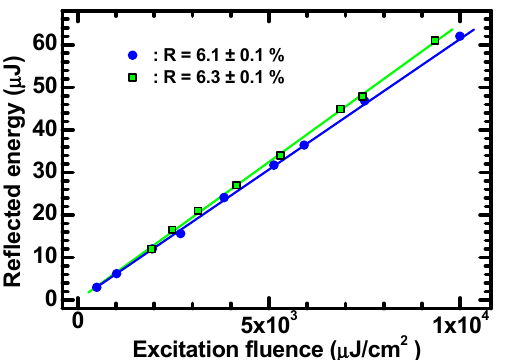
Figure 3. Reflected energy vs. excitation fluency at λ = 355 nm for two of the investigated ZnO crystals. The data refer to two ZnO crystals and indicate constant (i.e., linear) reflectivities of 6.1 ± 0.1% (sample 1, blue circles) and of 6.3 ± 0.1% (sample 2, green squares). A reference value of α ( λ = 355 nm) = 1.5 · 10 5 cm − 1 was taken from optical